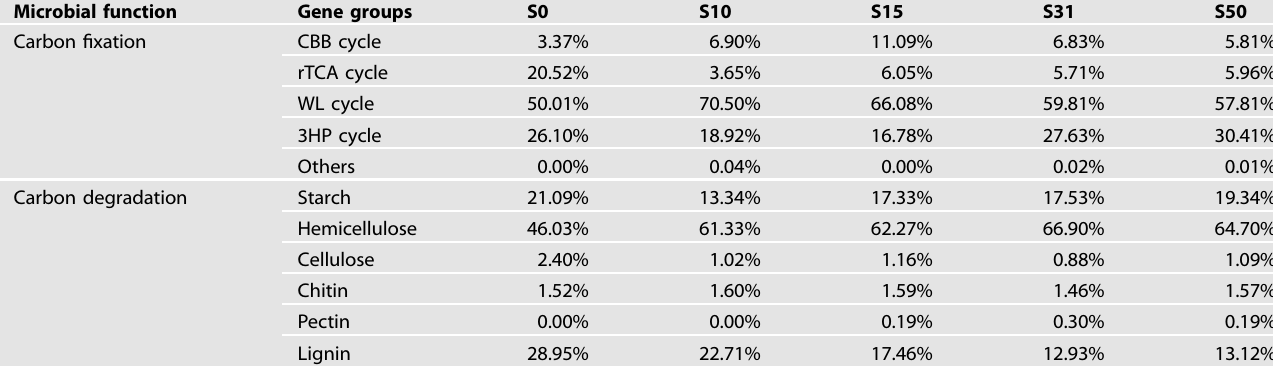
Table 1. Relative proportion of carbon functional gene groups in the glacier foreland of Laohugou Glacier No. 12. Microbial